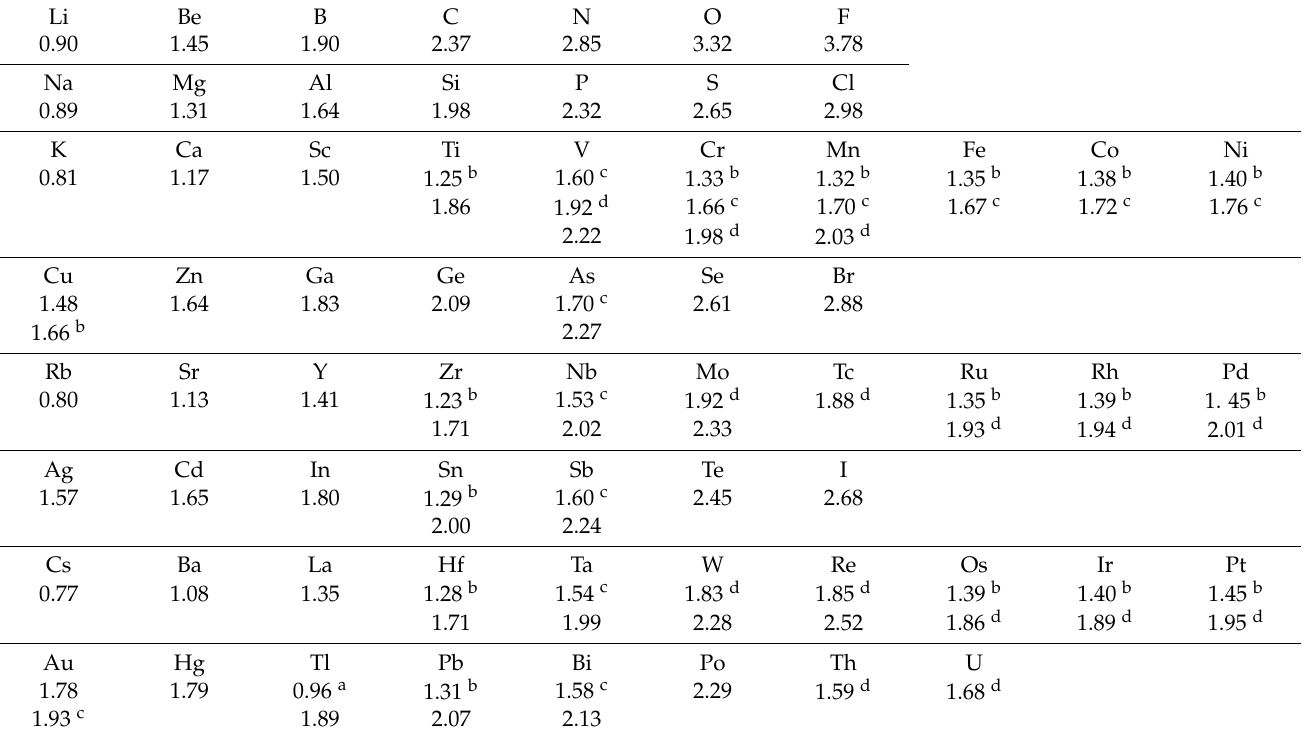
Table 1. Ionization electronegativity of free atoms.